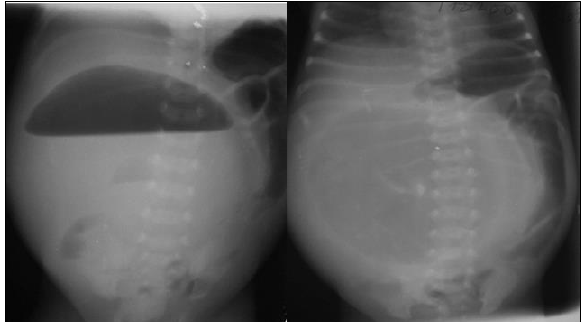
Figure 8: Giant cystic meconium peritonitis.